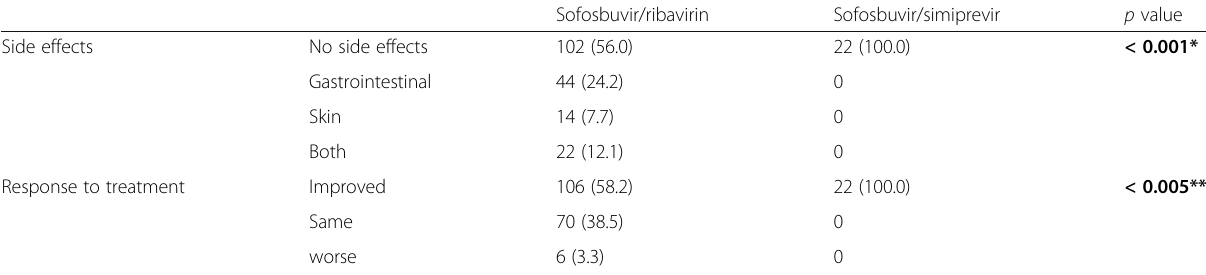
Table 7 Comparisons between the 2 protocols/regimens of double therapy as regards response to treatment and reported side